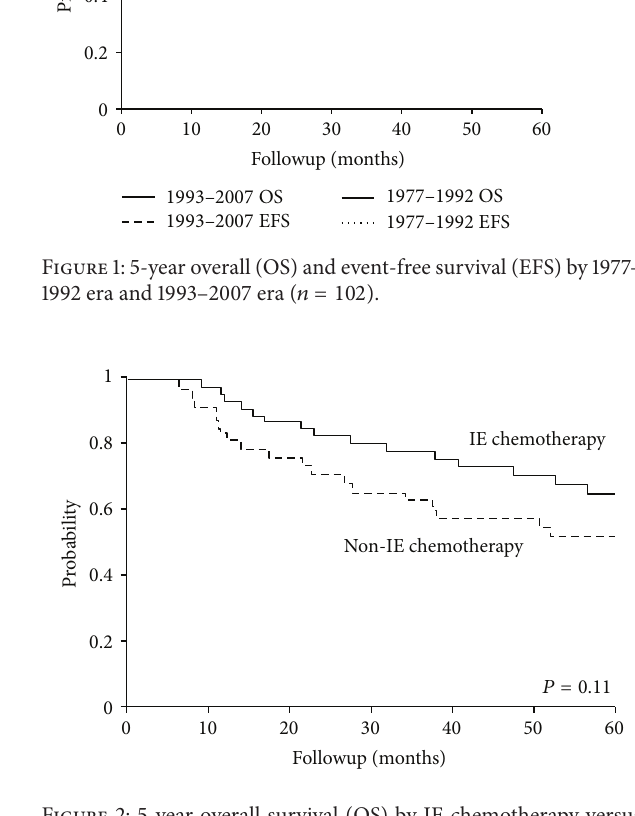
Figure 2: 5-year overall survival (OS) by IE chemotherapy versus non-IE chemotherapy ( 𝑛 = 89